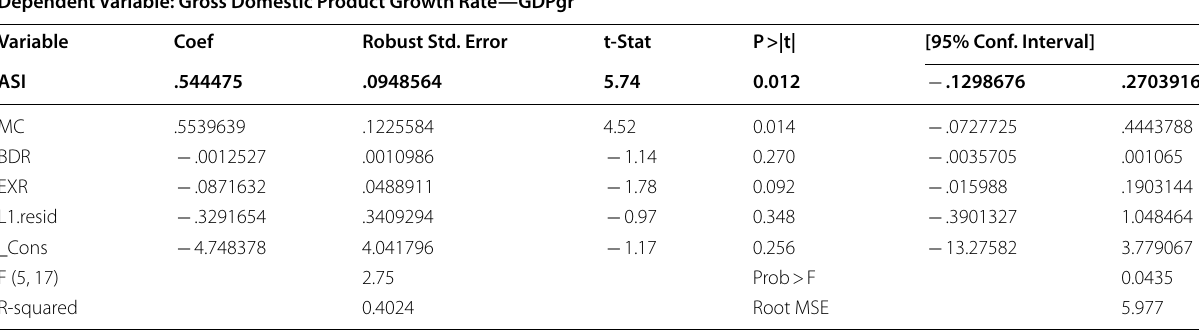
Table 8 Estimated results on share price fluctuations impact on economic growth. Source: Authors computation with data generated from NSE and